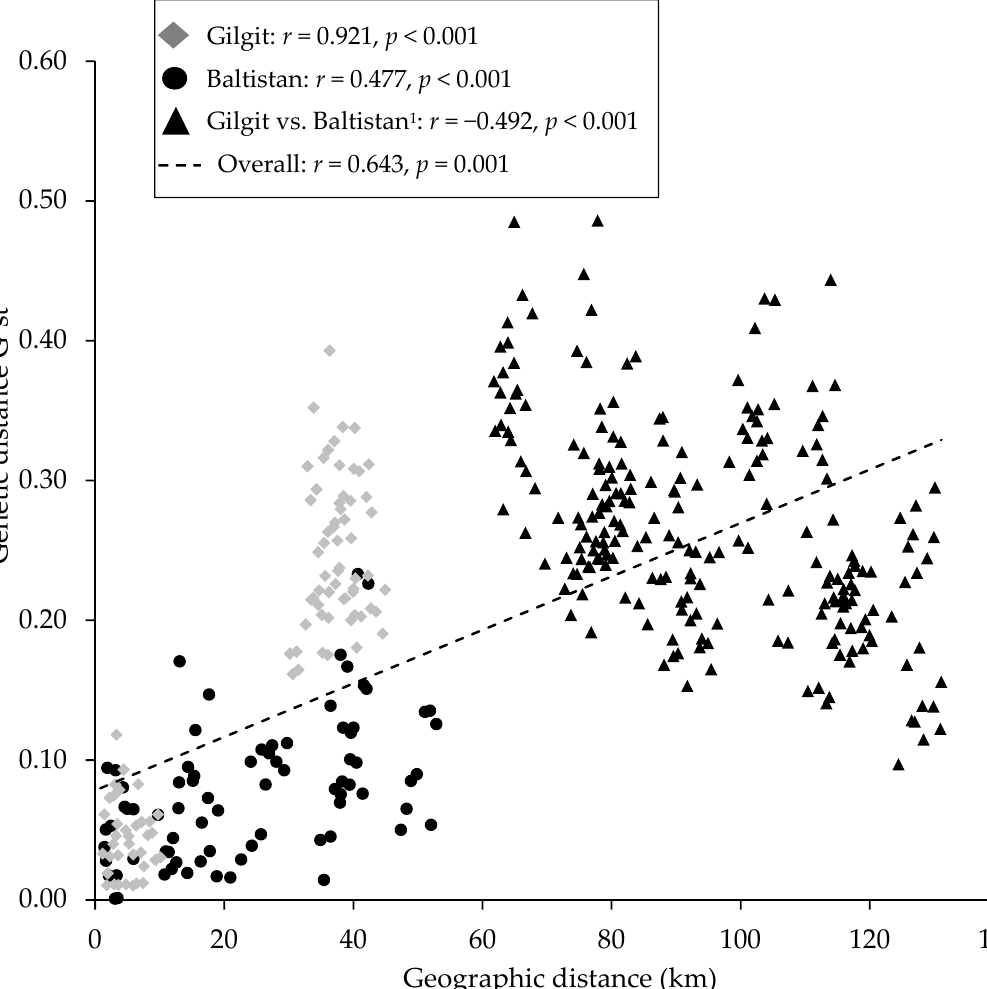
Figure 5. Correlations ( r ) between genetic and geographical distances in sea buckthorn based on the Mantel test for eight populations studied in Gilgit-Baltistan, Pakistan. 1 Pairwise comparisons between Gilgit and Baltistan populations.